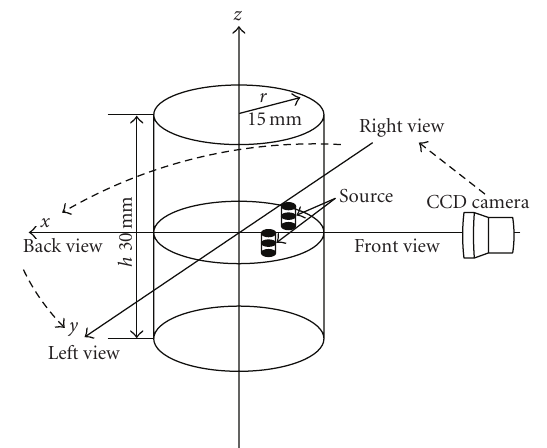
Figure 2: Schematic diagram of the multipleview bioluminescence imaging experiment.